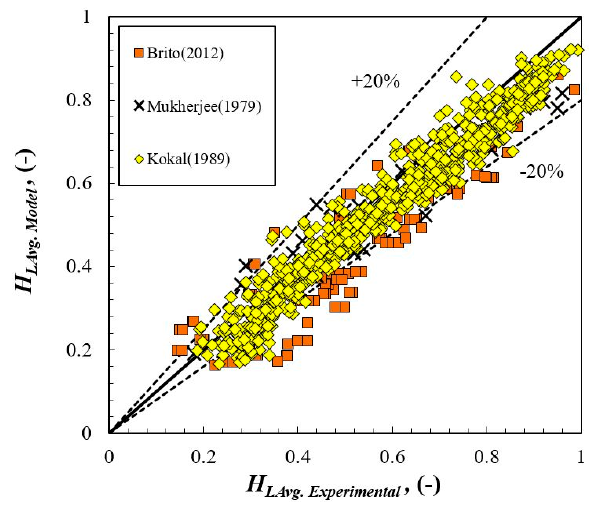
Figure 6. Relationship of measured average liquid holdup data and the predicted value from Woldesemayat & Ghajar [37] correlation.